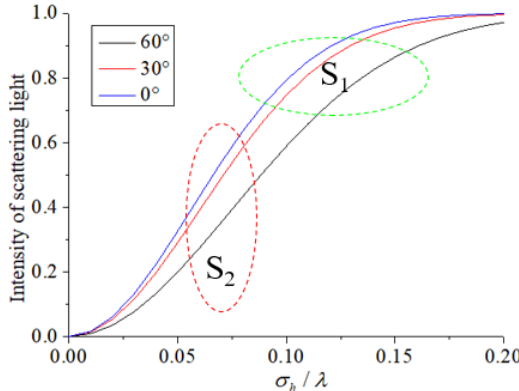
Figure 8. Scattering intensity as the ratio of the surface roughness and wavelength.